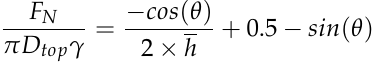
Figure 3. An example of the simulation boundaries. Inside the red lines, the surface energy is defined by low contact angle (10°). Outside the red lines, high surface energy is defined by large contact angle (110°–165°).